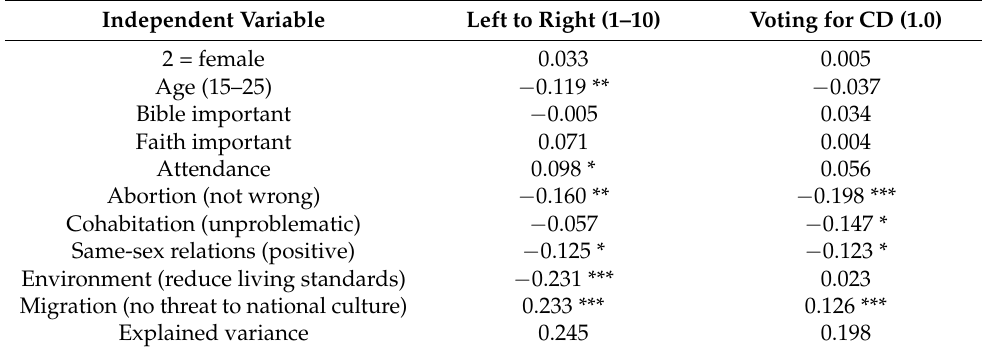
Table 5. Young evangelicals in Norway. Regression analyses with left-to-right party preference scale and voting for CD, or not, as dependent